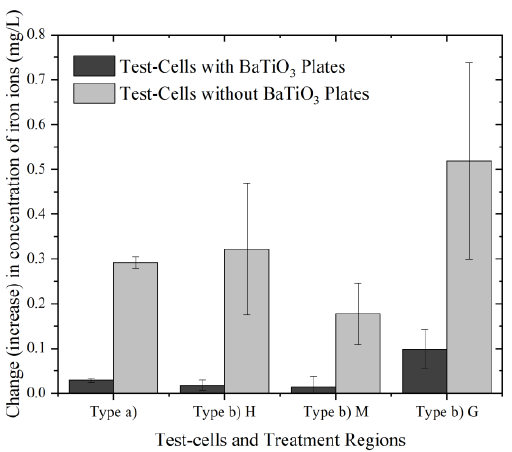
Figure 7. Effects of PEF treatment on the concentration of iron ions in yeast suspension using differ- ent types of chambers. Error bars show standard deviation (n = 3). Table 2. Statistical analysis of the experimental results of iron ions concentration (mg/L).